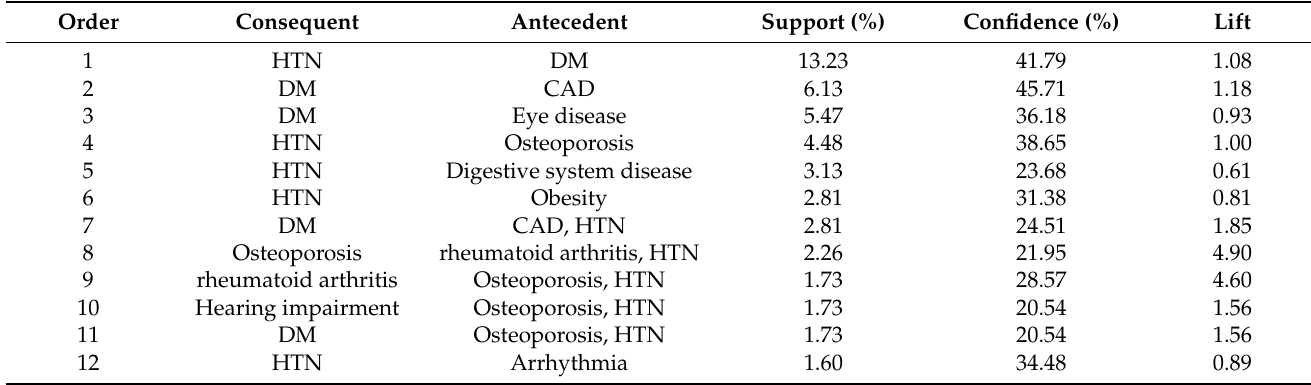
Table 2. Analysis results of multimorbidity dyads and triads by association rule.